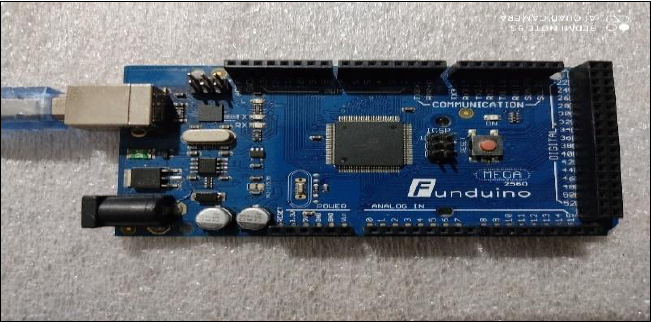
Figure 1: The Arduino Mega board uses a microcontroller ATmega328 onboard.